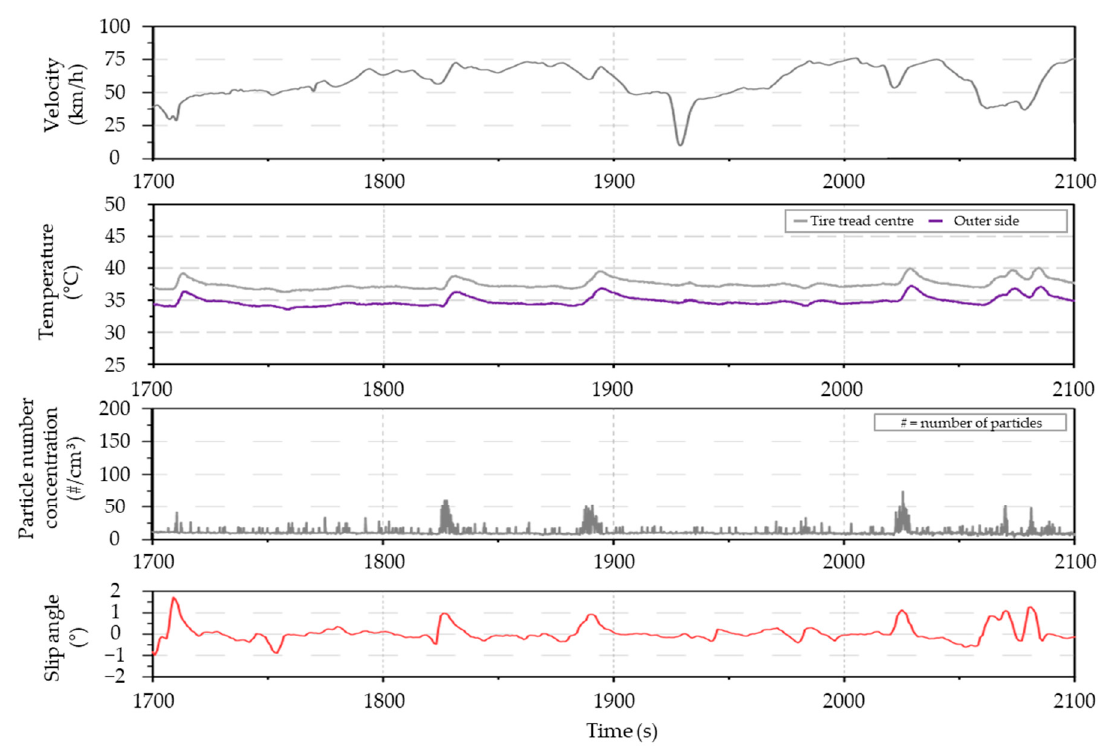
Figure 12. Correlation between vehicle speed, slip angle and particle number concentration on single-roller test bench–RDE test cycle